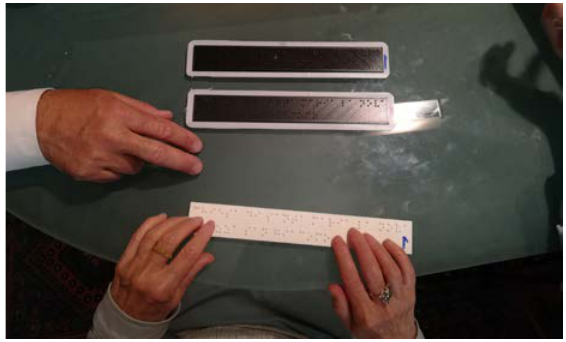
Figure 10. Test on different printed types of braille Those who do not have a high level of education or visual